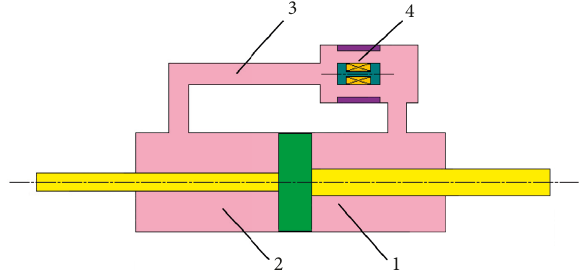
Figure 19: Hydromechanical model of the compressible magne- torheological strut: 1, chamber 1; 2, chamber 2; 3, tubing; 4, MR valve